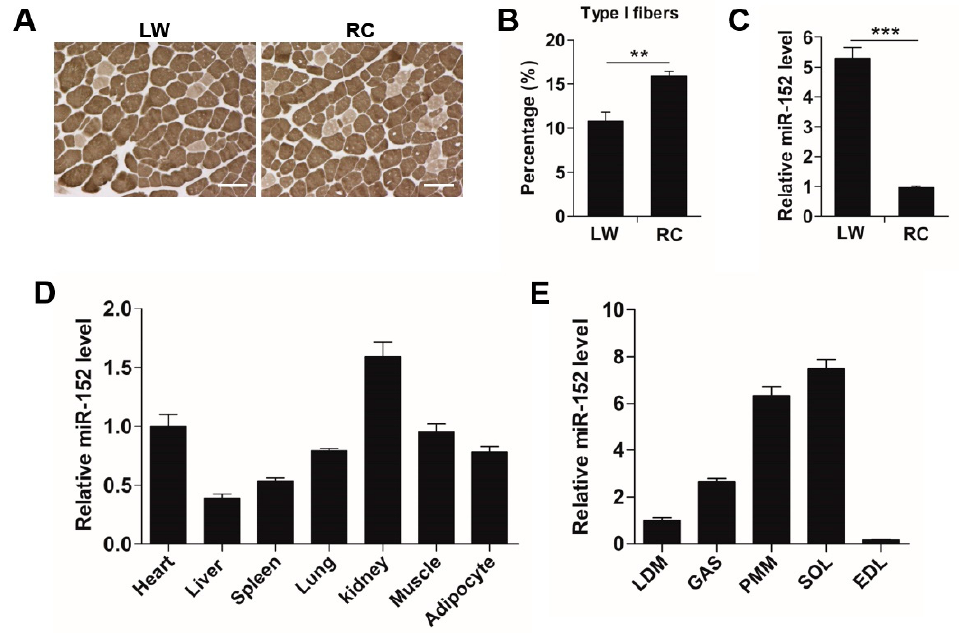
Figure 1. miR-152 is more abundant in the slow-twitch myofiber-enriched muscles. ( A ) Metachromatic adenosine triphosphatase (ATPase) staining of the longissimus dorsi (LD) muscles from large white (LW) and Rongchang (RC) pigs ( n = 5, five pigs). Type I fibers stain light gray. Original magnification, × 100. Bars: 100 µ m. ( B ) Proportion of the slow-twitch fiber was analyzed in the LD muscles from LW and RC pigs based on the ATPase staining. ( C ) miR-152 expression in the LD muscles from both LW and RC pigs was determined by RT-PCR ( n = 5, five pigs). ( D ) Tissue distribution of miR-152 in adult LW pigs ( n = 5, five pigs). ( E ) Expression of miR-152 in di ff erent types of skeletal muscle in adult LW pigs ( n = 5, five pigs). Results are exhibited as mean ± S.E.M. ** p < 0.01 and *** p < 0.001 when contrasted with the control.